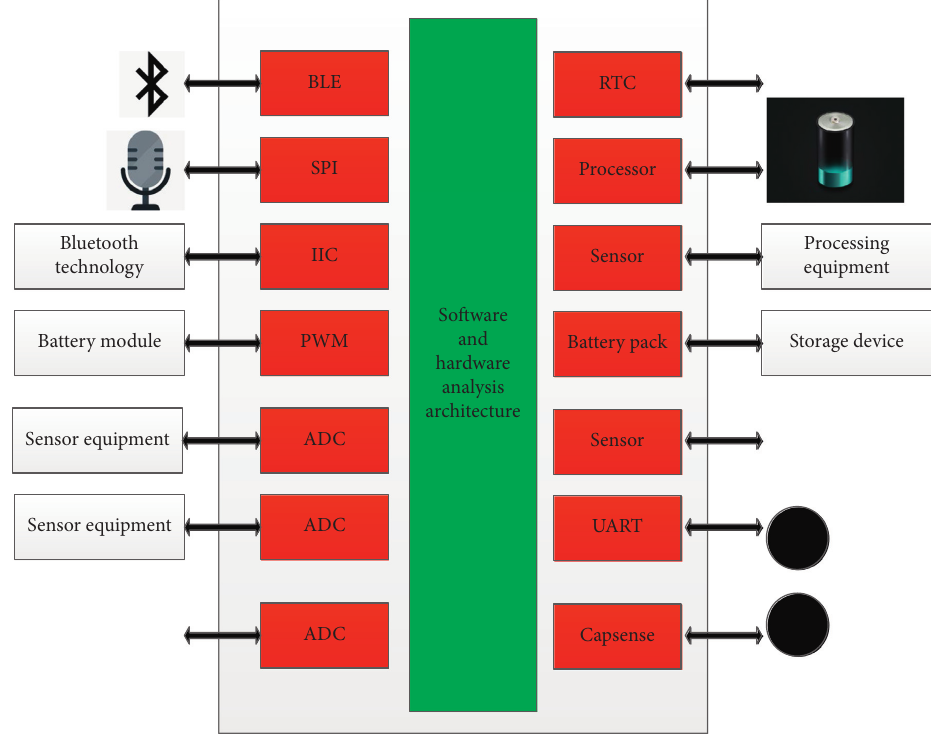
Figure 3: Overall framework of wearable intelligent